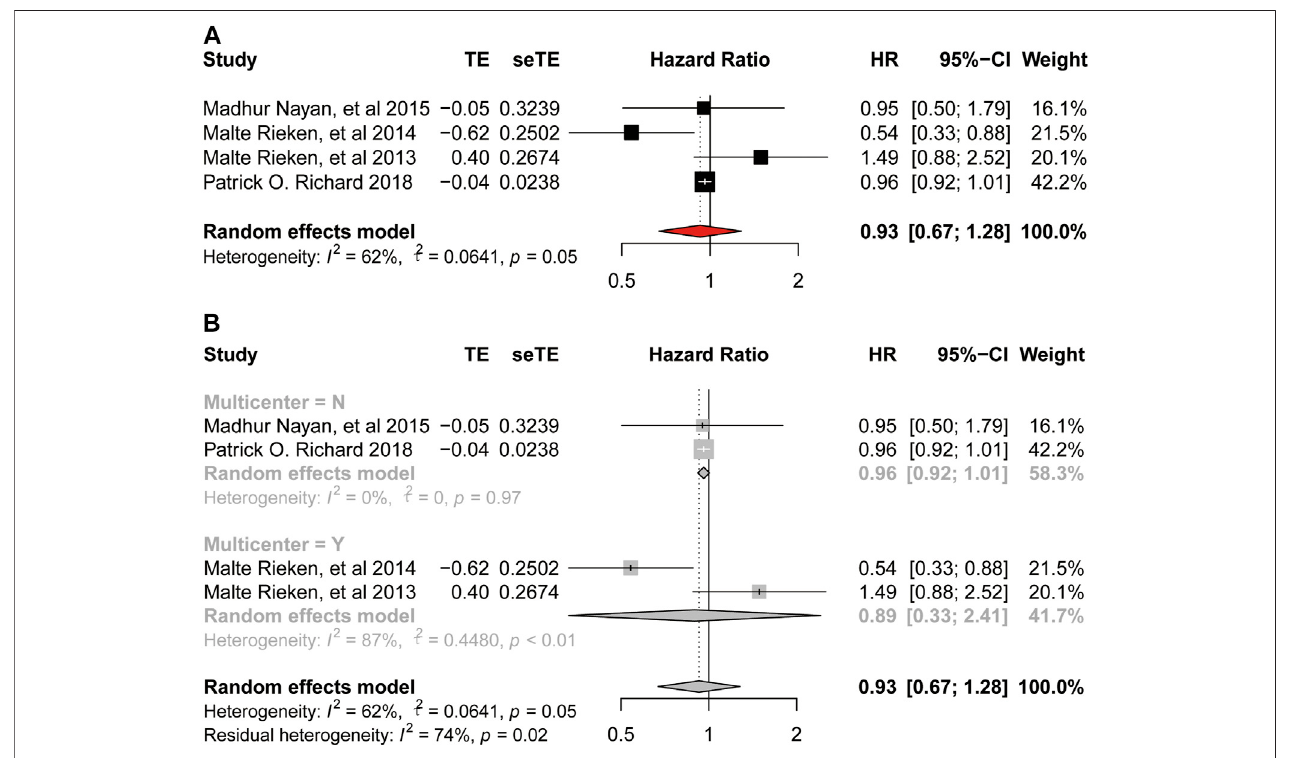
FIGURE 3 | Forest plot of hazard ratio for overall survival (A) Association between use of metformin and OS of bladder cancer. (B) Subgroup analysis based on whether it is multicenter.